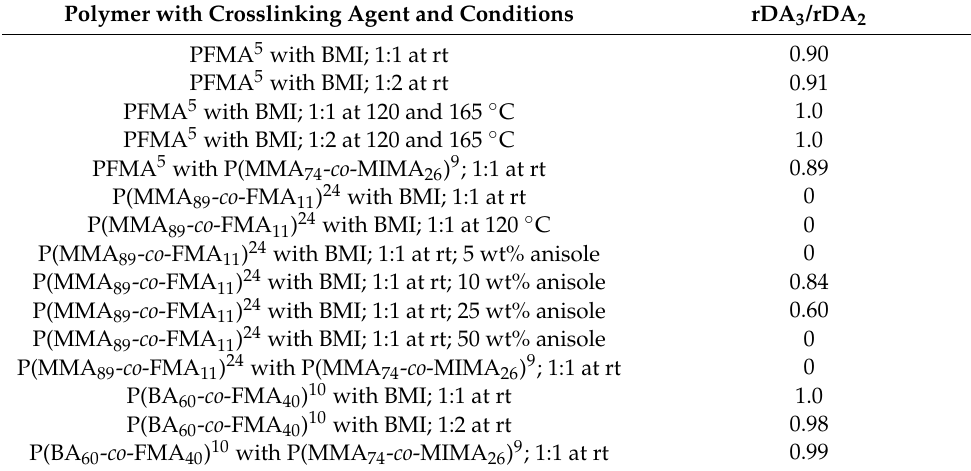
Table 3. Ratios of the endotherms of the retro-Diels-Alder reaction during the second and third heating. Polymer with Crosslinking Agent and Conditions